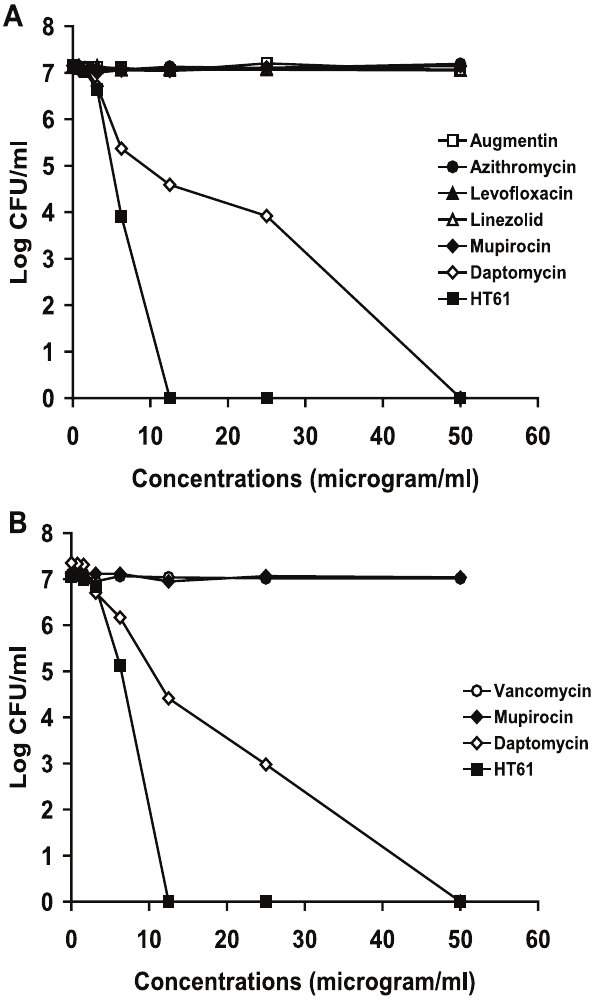
Figure 2. Effects of HT61 and marketed antibiotics against stationary phase non-multiplying MSSA and MRSA. HT61 and the antibiotics were added to the non-multiplying cultures at different concentrations. CFU counts were carried out after 24 hours of